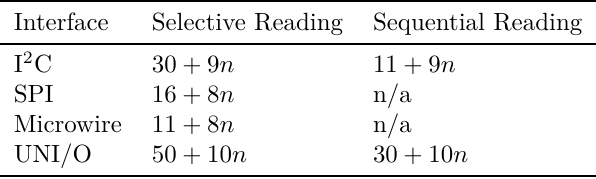
Table 1: Overview of required clock cycles for reading n consecutive memory words using different interfaces and read operations for 8-bit memory words and addresses. SPI and Microwire only offer selective reading. Sequential reading is therefore not directly available, indicated by